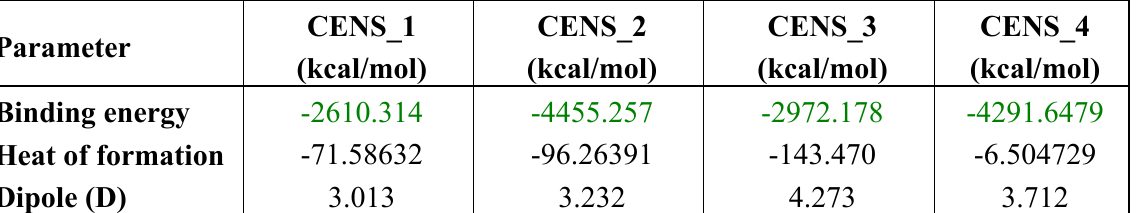
Table 2: Bonding energy, heat of formation (kcal/mol) and electric dipoles (Debye) for the four CENS as calculated by the PM3 semi-empirical